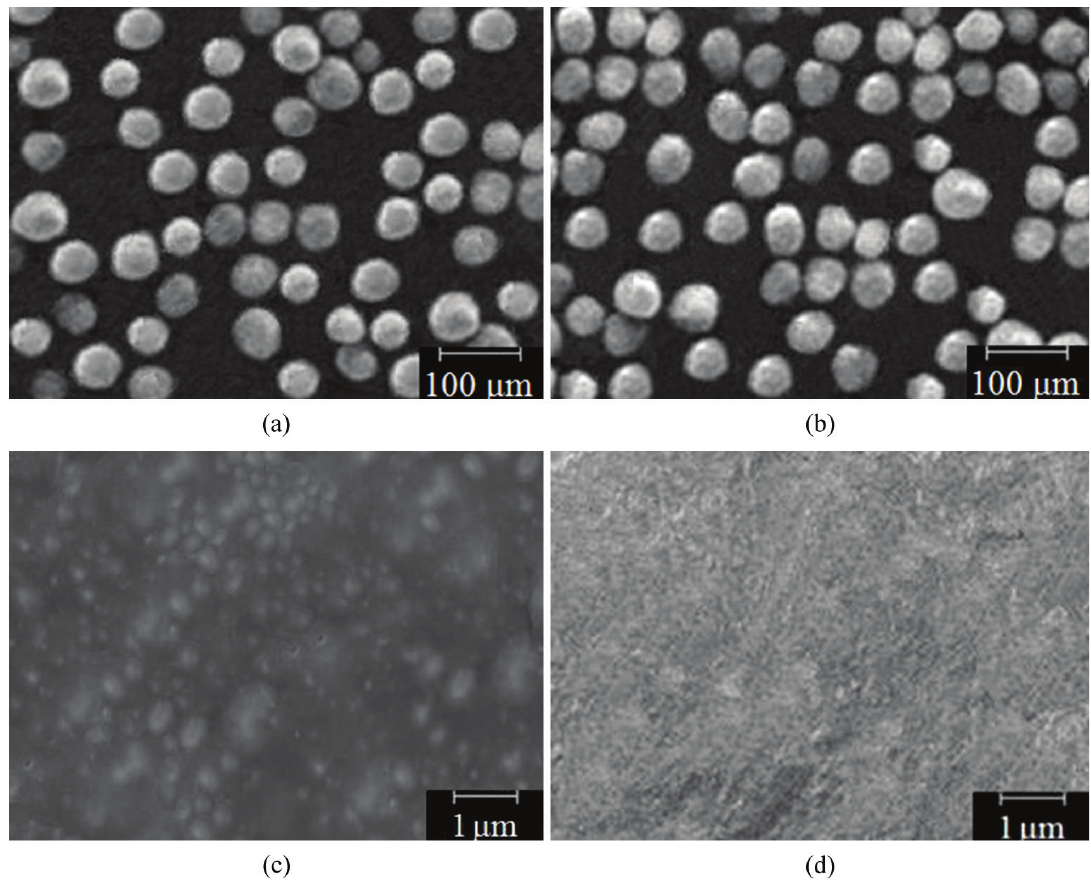
Figure 1. Scanning electron micrographs of the microspheres: (a,c) collagen microspheres encapsulating steroidal saponins and (b,d) pure collagen microspheres. (c) and (d) are magnifications of (a) and (b),